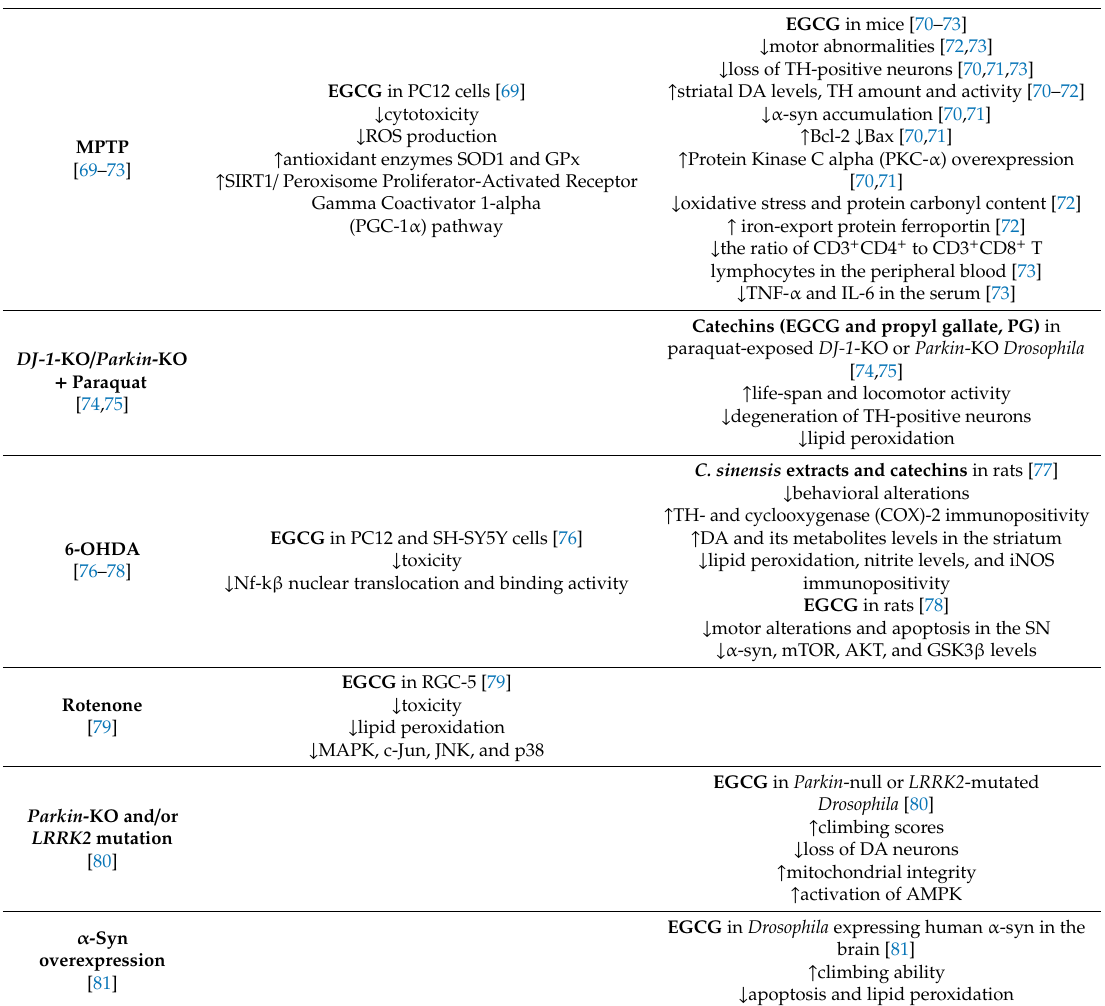
Table 3. Neuroprotective e ff ects of Camellia sinensis in PD